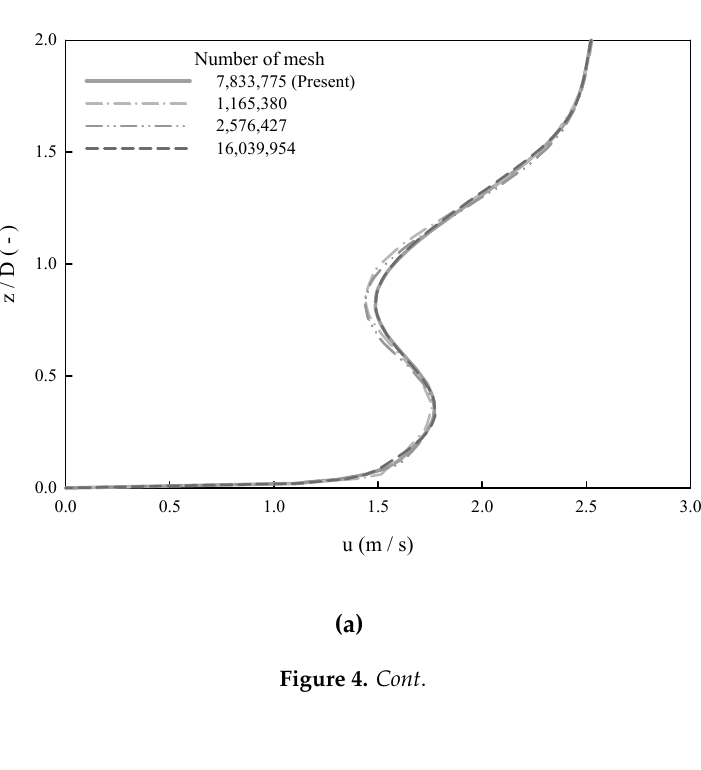
Figure 3. Disk boundary conditions.